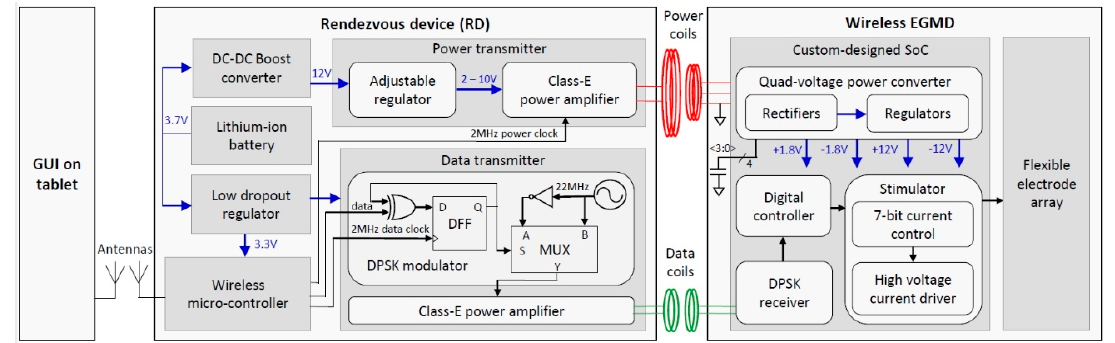
Figure 2. Functional block diagram of wireless GI modulation system.